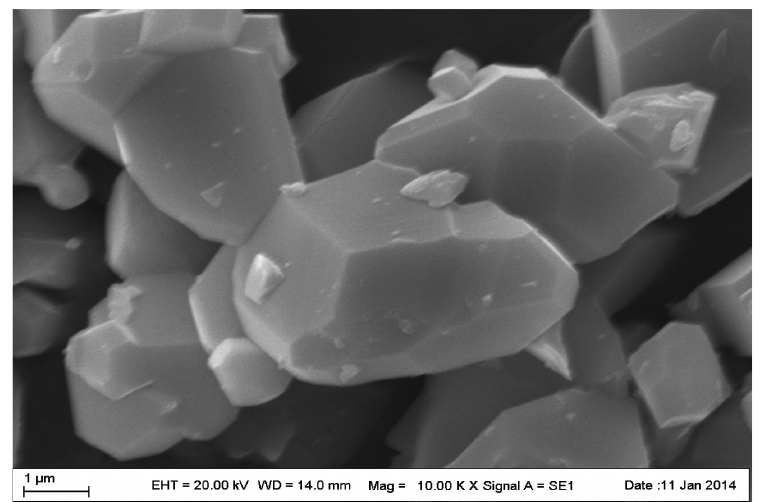
Fig. 3: SEM image of LiNi 0.5 Mn 1.5 O 4 powders